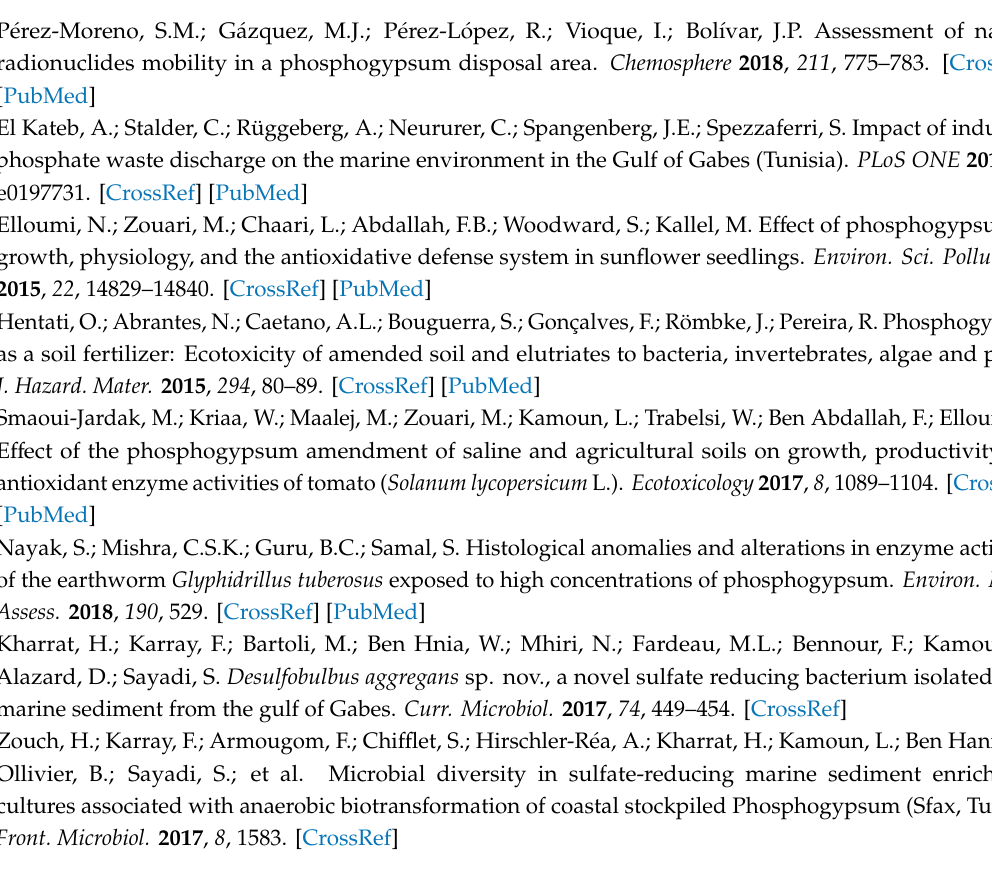
Supplementary Experimental, Figure S1: (A) Bacterial community (B) rarefaction curve and (C) functional analysis of phosphogypsum and four plants ( Arthrocnemum indicum , Mesembryanthemum nodiflorum , Suaeda fructicosa and Suaeda mollis ) provided by Qiime program, Figure S2: Heat map of bacterial community of phosphogypsum and four plants ( A. indicum , M. nodiflorum , S. fructicosa and S. mollis ) provided by SEED2 program in (A) family (B) genera and (C) species level, Figure S3: 16S-rDNA phylogenetic analysis of bacteria recovered from phosphogypsum, Figure S4: 16S-rDNA phylogenetic analysis of bacteria recovered from A. indicum , Figure S5: 16S-rDNA phylogenetic analysis of bacteria recovered from M. nodiflorum , Figure S6: 16S-rDNA phylogenetic analysis of bacteria recovered from S. fruticose , Figure S7: 16S-rDNA phylogenetic analysis of bacteria recovered from S. mollis , Table S1: List and description of the Bacillus albus isolates used in the study, Table S2: ICP-OES for phosphogypsum